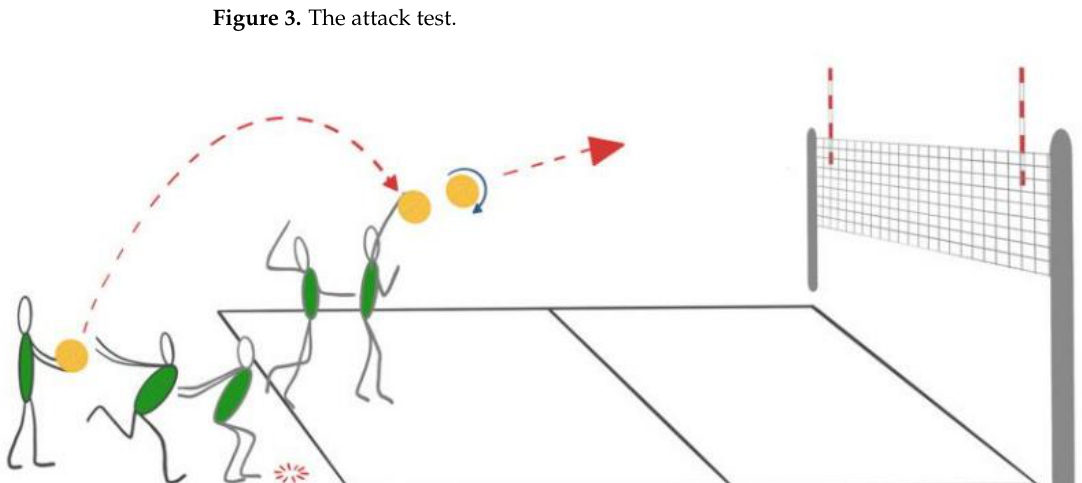
Figure 3. The attack test.